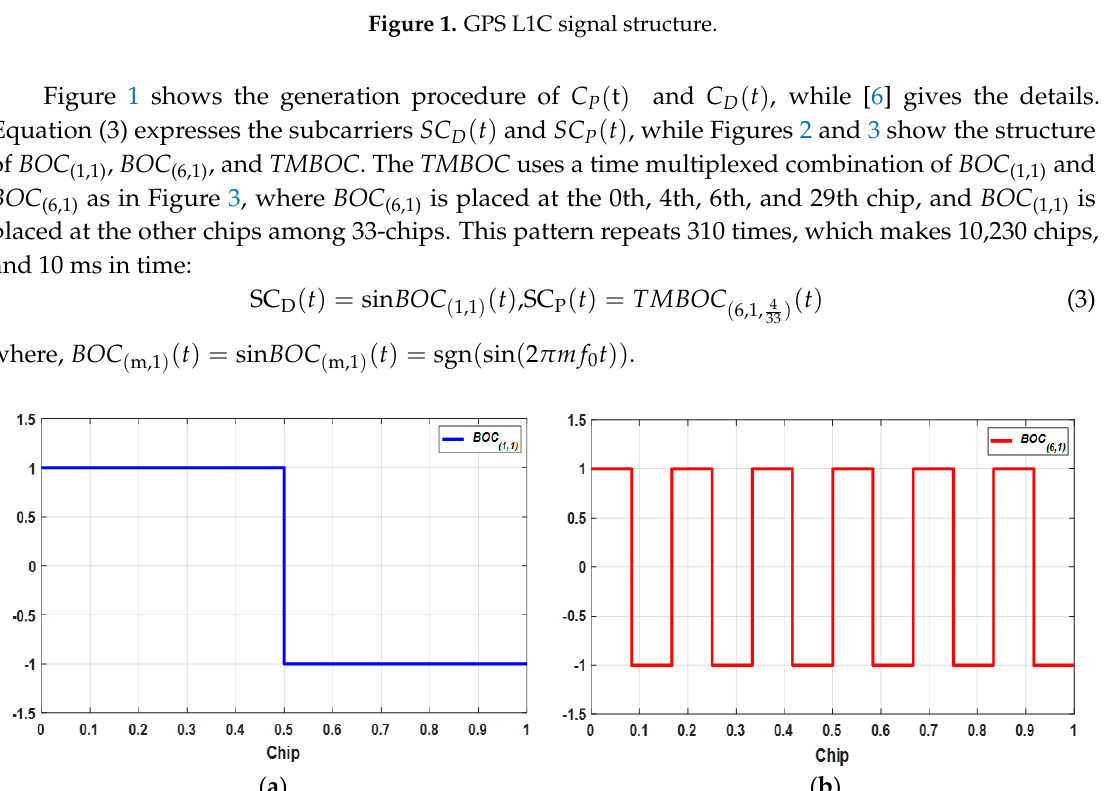
Figure 2. BOC modulation; ( a ) BOC (1,1) ; ( b ) BOC (6,1) .